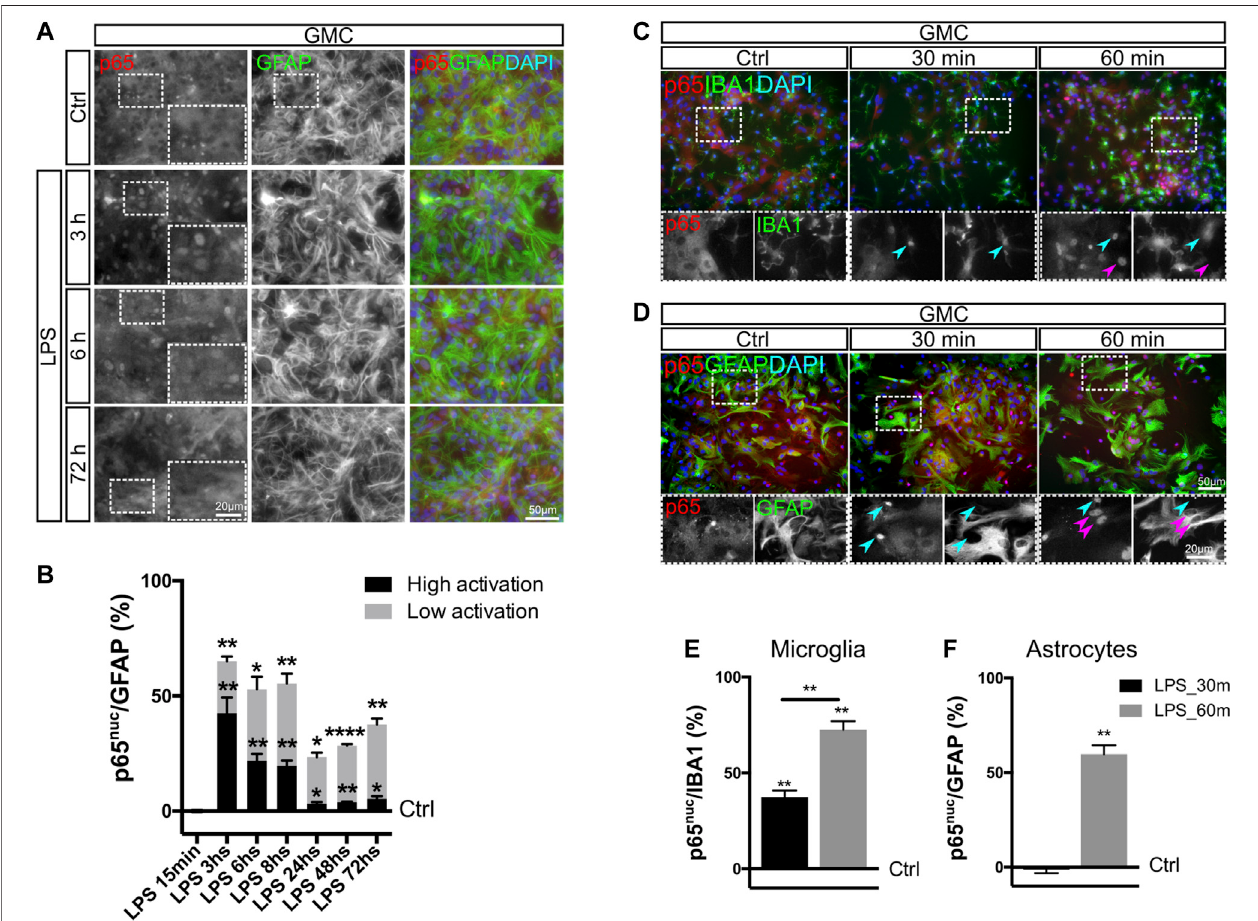
FIGURE2| NF- κ Bactivationinmicrogliaoccursfasterthaninastrocytes. (A) Glialmixedcultures(GMCs)wereincubatedwithLPSduringtheindicatedtimepoints in reduced-serum medium. To analyze NF- κ B activation in astrocytes in response to LPS, we performed double immuno fl uorescence staining for GFAP and p65, determining the nuclear p65 localization (p65 nuc ). (B) Graph showing the proportion of GFAP + /p65 nuc cells from the total GFAP-positive cells after subtracting the percentageofGFAP + /p65 nuc undercontrolconditions (Ctrl (cid:2) 0). Bars showthemeanpercentage ofthreetofour biologicalreplicateswiththeSEM.Low activation corresponds to GFAP + astrocytes, in which p65 nuc and cytoplasmic p65 (p65 cyt ) staining was homogeneous. High activation corresponds to GFAP + astrocytes with distinguishable p65 nuc staining.Each timepointwascompared totherespectivecontrol(noLPS)usingone-sample t -testwiththestatisticalsigni fi cance represented as * p < 0.05,** p < 0.01,or**** p < 0.0001; n (cid:2) 3 – 4. (C,D) Glialmixedcultures(GMCs)wereincubatedwithLPSduringtheindicatedtimepointsinreduced-serummedium. To address p65 nuc in microglia and astrocytes in response to LPS, we performed double immuno fl uorescence staining for Iba-1 and p65 (C) or GFAP and p65 (D), respectively. (E) Graphshowingtheproportion ofIba-1 + /p65 nuc – positive cellsfrom thetotal Iba-1 – positivecells after subtractingthepercentage ofIba-1 + /p65 nuc under control conditions (Ctrl (cid:2) 0). Each time point was compared to the respective control (no LPS) using one-sample t -test with the statistical signi fi cance represented as ** p < 0.01;n (cid:2) 3.Comparisonbetweentreatments(timepoints)wasconductedusingStudent ’ st-testwiththestatisticalsigni fi cancerepresentedas** p < 0.01; n (cid:2) 3. (F) Graph showing the percentage of GFAP + /p65 nuc -positive cells from the total GFAP-positive cells after subtracting the percentage of GFAP + /p65 nuc from the control (Ctrl (cid:2) 0). Each time point was compared to the respective control (no LPS) using one-sample t -test with the statistical signi fi cance represented as ** p < 0.01; n (cid:2)